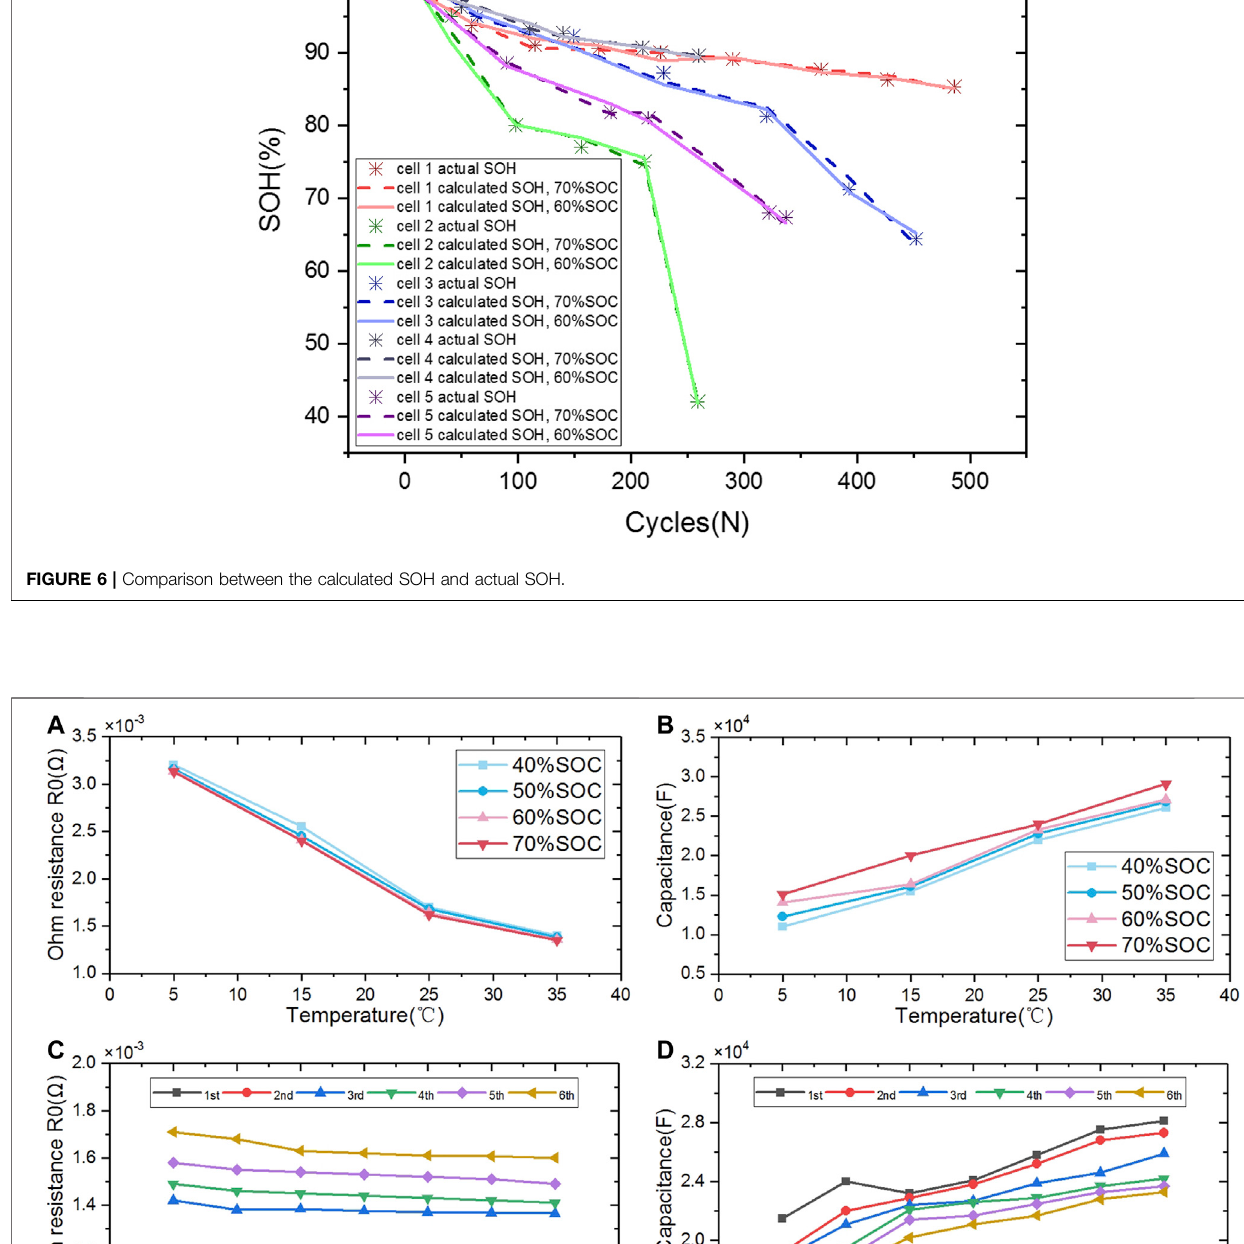
Frontiers in Energy Research |